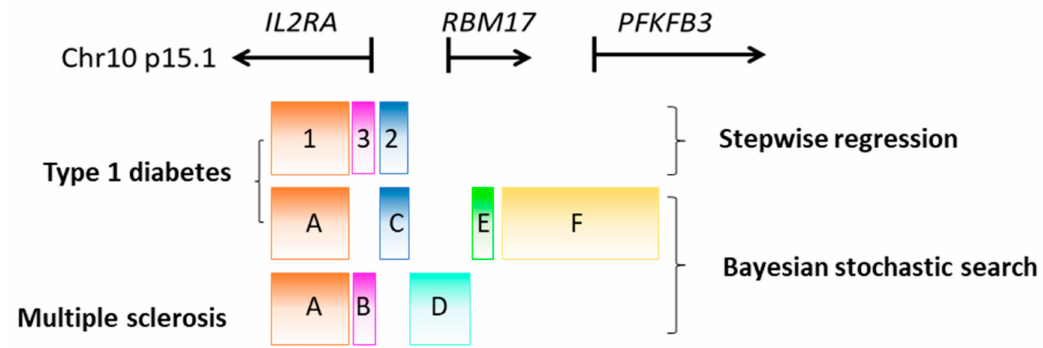
Figure 1. Schematic representation of multiple independent associations at the IL2RA-RBM17-PFKFB3 region discovered using stepwise regression and Bayesian stochastic search that are associated with both type 1 diabetes and multiple sclerosis. Group 1–3 single nucleotide polymorphisms that contribute to type 1 diabetes were originally identified using stepwise regression. The later-developed Bayesian stochastic search, however, identified four groups of SNPs (A, C, E, F) that jointly explain type 1 diabetes risk at the IL2RA locus; whereas for multiple sclerosis, the risk at this locus was explained by Group A and D jointly, or by Group B SNPs alone. Figure was adapted and modified from